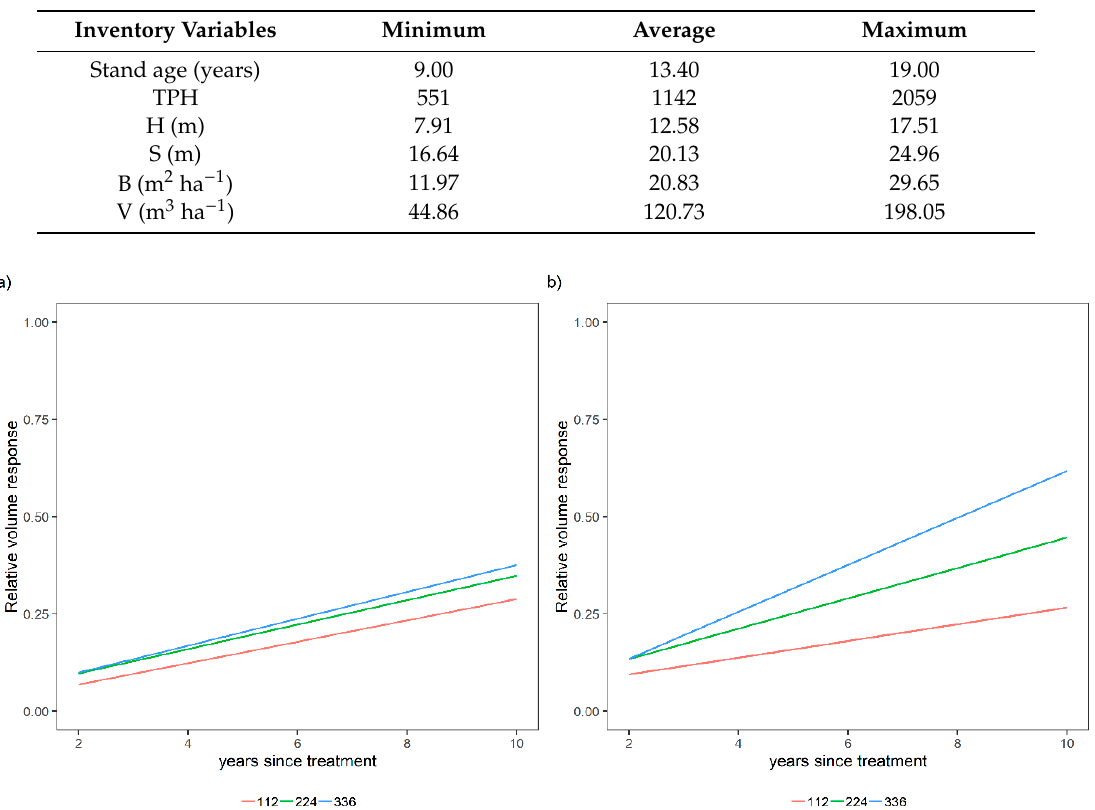
Table 3. Summary statistics of the RW13 study at establishment for stand age, number of live trees